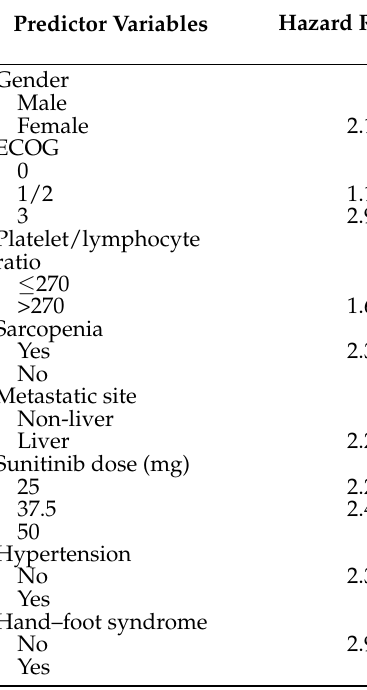
Table 3. Multivariate Cox regression model of factors predicting the progression-free